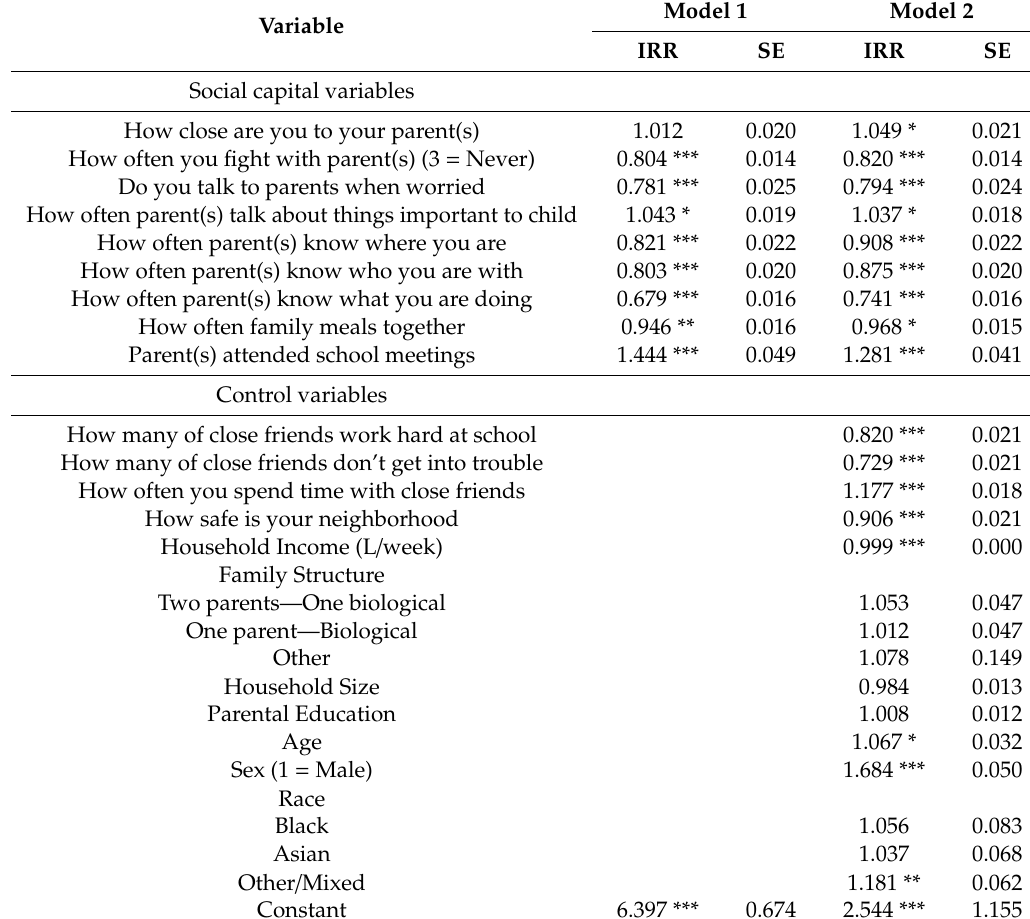
Table 3. Negative Binomial Regression of Social Capital Indicators on Delinquency Index